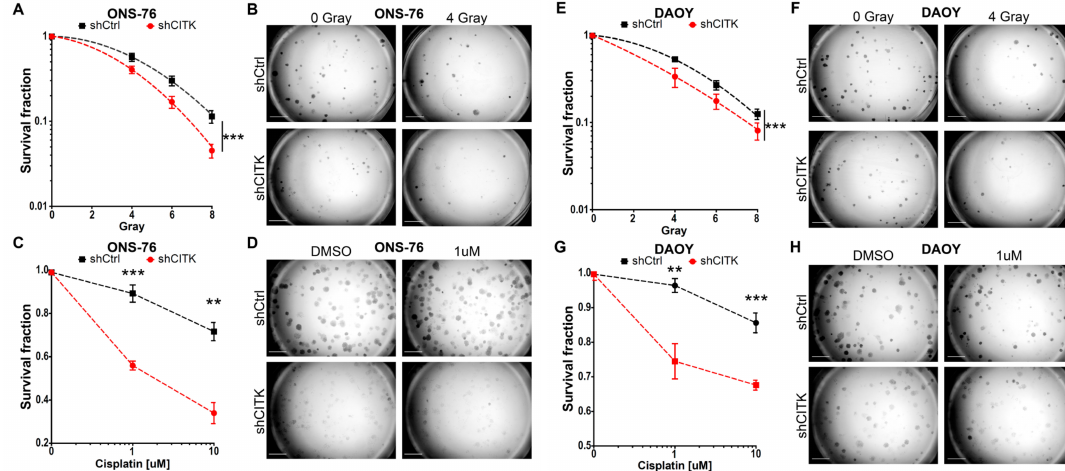
Figure 6. CITK knockdown potentiates the e ff ects of radiation and cisplatin treatment in ONS-76 and DAOY cell lines. ( A ) ONS-76 stably transfected with inducible nontargeting (shCtrl) or CITK-specific shRNA sequences were plated in doxycycline-containing medium (2 µ mol / L) and irradiated at the indicated doses 48 h later. After five days, colonies were fixed and stained with crystal violet. The shCtrl and shCITK curves were obtained by fitting the values into a nonlinear regression model, and curves were compared with Extra sum-of-squares F test. ( B ) Phase contrast images of representative fields of ONS-76 expressing shCtrl and shCITK five days after radiation. ( C ) ONS-76 cells expressing shCtrl or CITK-specific shRNA were plated in doxycycline-containing medium (2 µ mol / L) and, after 48 h, treated with 1 or 10 µ M of cisplatin for 1 hour. Cells were then washed, and fresh medium was added. Colonies were stained after five days, with crystal violet. ( D ) Phase contrast images of representative fields obtained from ONS-76 cells expressing shCtrl and shCITK five days after 1 µ M of cisplatin treatment. ( E ) DAOY stably transfected with inducible nontargeting (shCtrl) or CITK-specific shRNA were plated in doxycycline-containing medium (2 µ mol / L) and, after 48 h, irradiated at the indicated doses. After five days, the colonies were fixed and stained with crystal violet. The curves were obtained and analyzed as in ( A ). ( F ) Phase contrast images of representative fields of DAOY expressing shCtrl and shCITK five days after radiation. ( G ) DAOY cells expressing shCtrl or CITK-specific shRNA were plated in doxycycline-containing medium (2 µ mol / L) and, after 48 h, treated with 1 or 10 µ M of cisplatin for 1 h. Cells were then washed, and fresh medium was added. Colonies were stained after five days, with crystal violet. ( H ) Phase contrast images of representative fields of DAOY expressing shCtrl and shCITK five days after 1 uM of cisplatin treatment. All quantifications were based on five independent biological replicates. Error bars, SEM. **, p < 0.01; ***, p < 0.001; two-tailed Student’s t -test for each